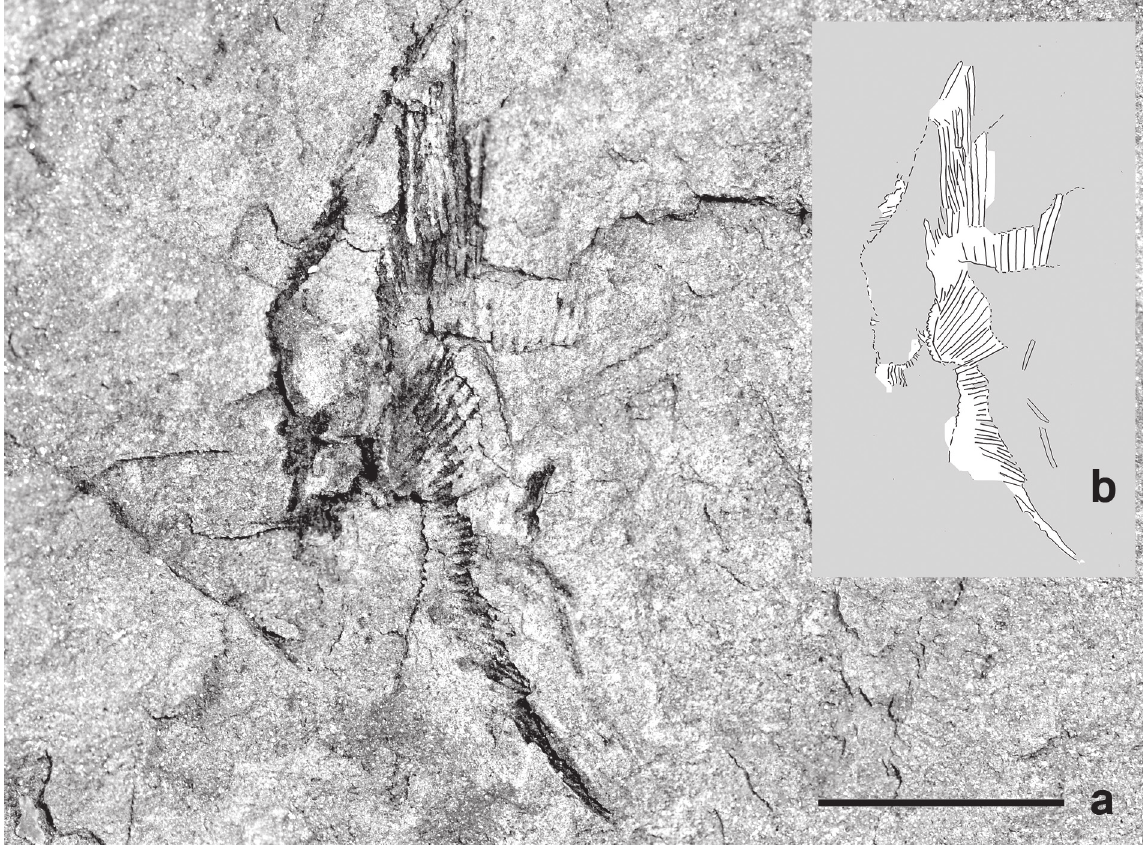
Figure 6 - UEPG/DEGEo/MPI 10709. Partially articulated remains of a chondrichthyan fin. a . Photograph of the specimen showing only impressions (natural casts) of radial elements; b . Interpretative drawing. Scale=